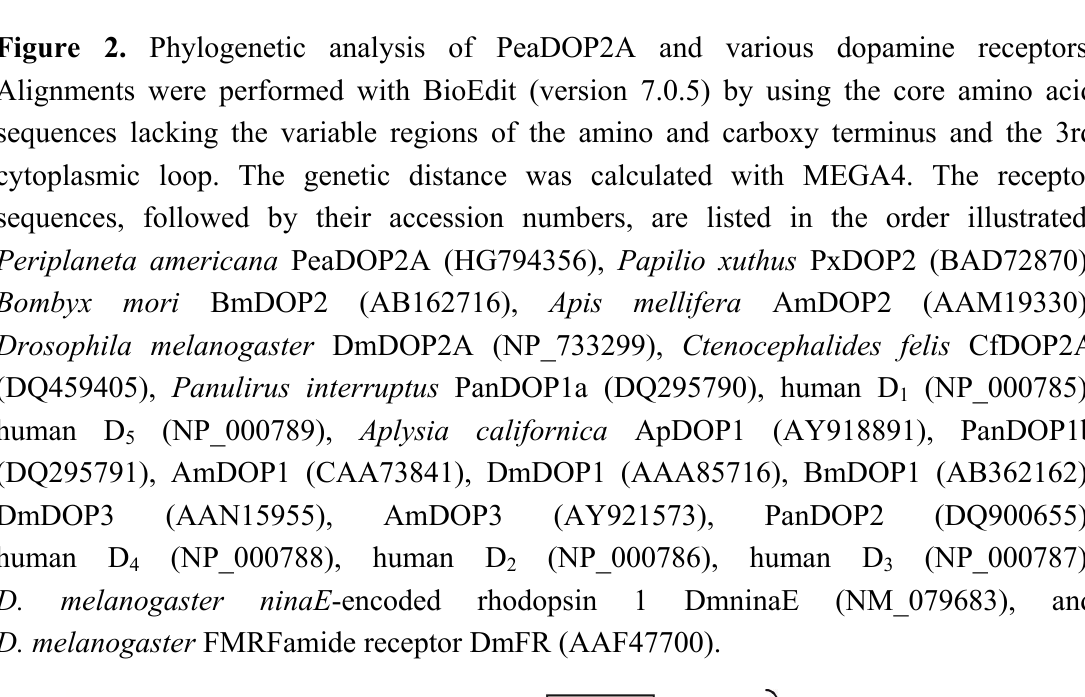
Figure 2. Phylogenetic analysis of PeaDOP2A and various dopamine receptors. Alignments were performed with BioEdit (version 7.0.5) by using the core amino acid sequences lacking the variable regions of the amino and carboxy terminus and the 3rd cytoplasmic loop. The genetic distance was calculated with MEGA4. The receptor sequences, followed by their accession numbers, are listed in the order